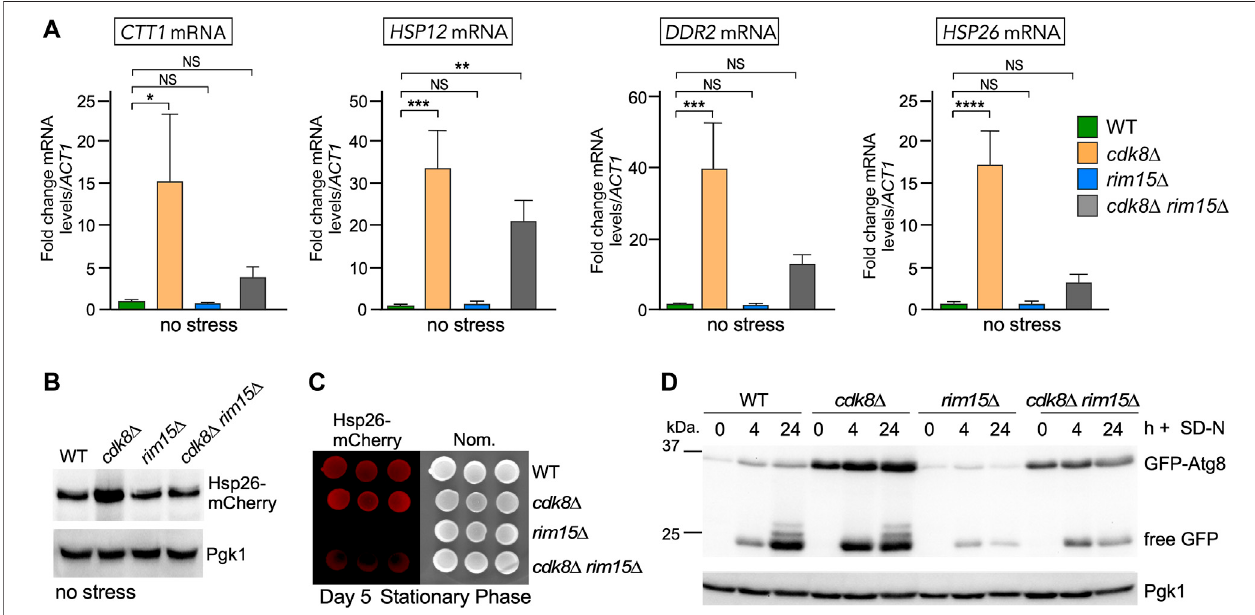
FIGURE 3 | Cdk8 repression is partially mediated through Rim15. (A) RT-qPCR assays probing for mRNA of the genes shown in the indicated strains. Transcript levels are given relative to the internal ACT1 mRNA control. For all RT-qPCR assays, the error bars indicate the standard deviation from the mean of two technical replicates from three mid-log, independent cultures. NS p ≥ 0.05; * p ≤ 0.05; ** p ≤ 0.01; *** p ≤ 0.005; **** p ≤ 0.001. (B) Representative Western blot of Hsp26-mCherry harvested from mid-log cultures of the indicated strains. (C) Visualization of Hsp26-mCherry using fl uorescence imaging in the strains shown following 5 days in stationaryphase.Threereplicatesareshown. (D) GFP-Atg8 cleavageassaysbeforeandafternitrogen starvationintheindicatedstrains.Forallblots,Pgk1wasusedas a loading